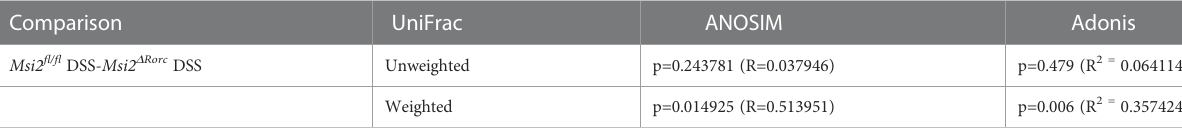
TABLE 1 ANOSIM and Adonis analysis between groups